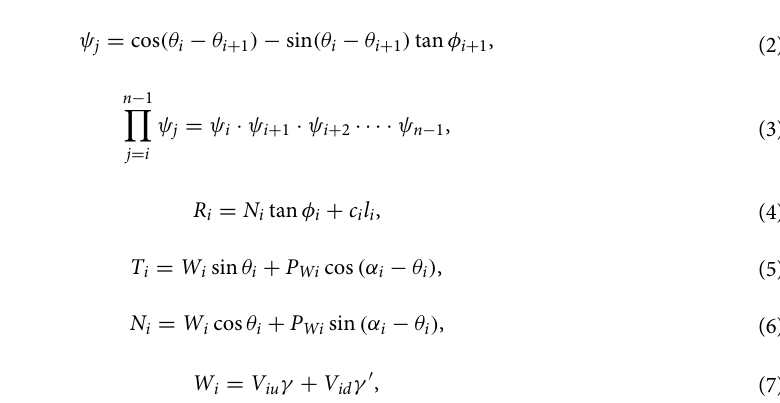
Figure 8. Automatic total station deformation monitoring system. ( a–c ) Show the prisms placed in the field; ( d ) shows the automatic total station placed in the observation